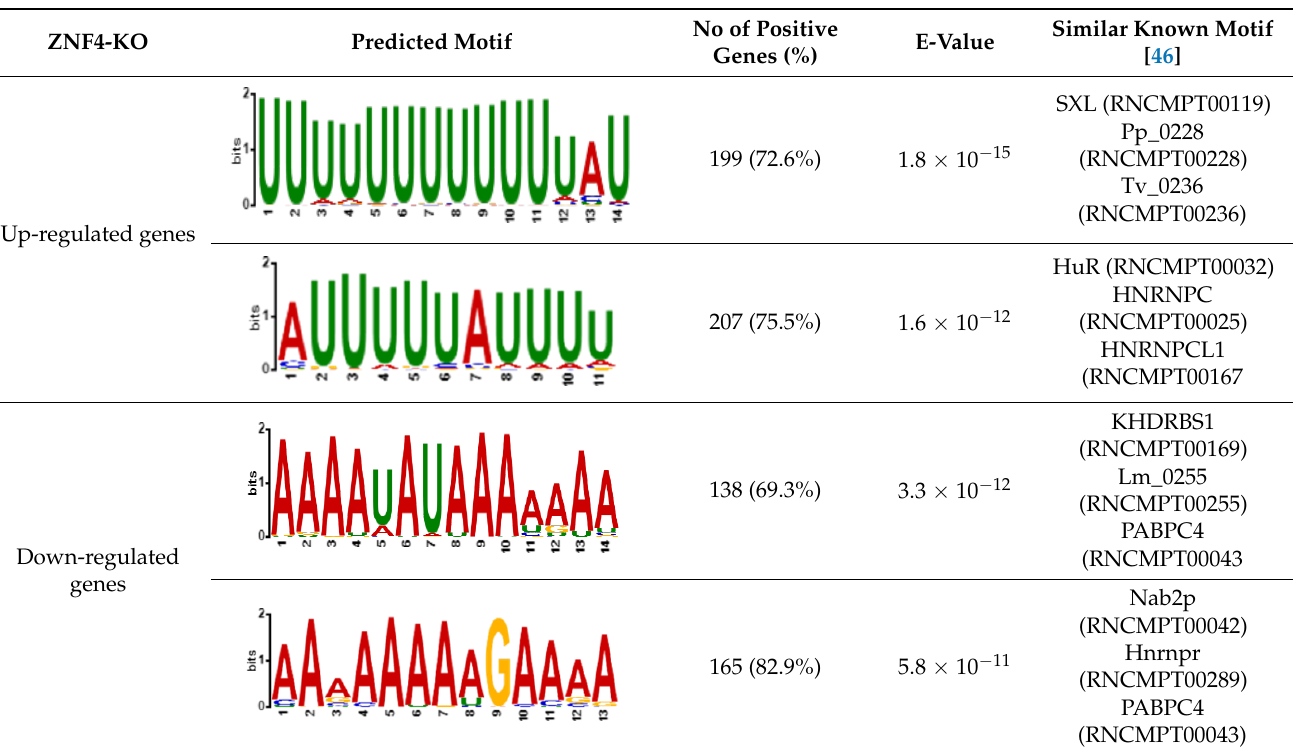
Table 1. Predicted binding motif for ZNF4-KO in the upregulated and downregulated genes.